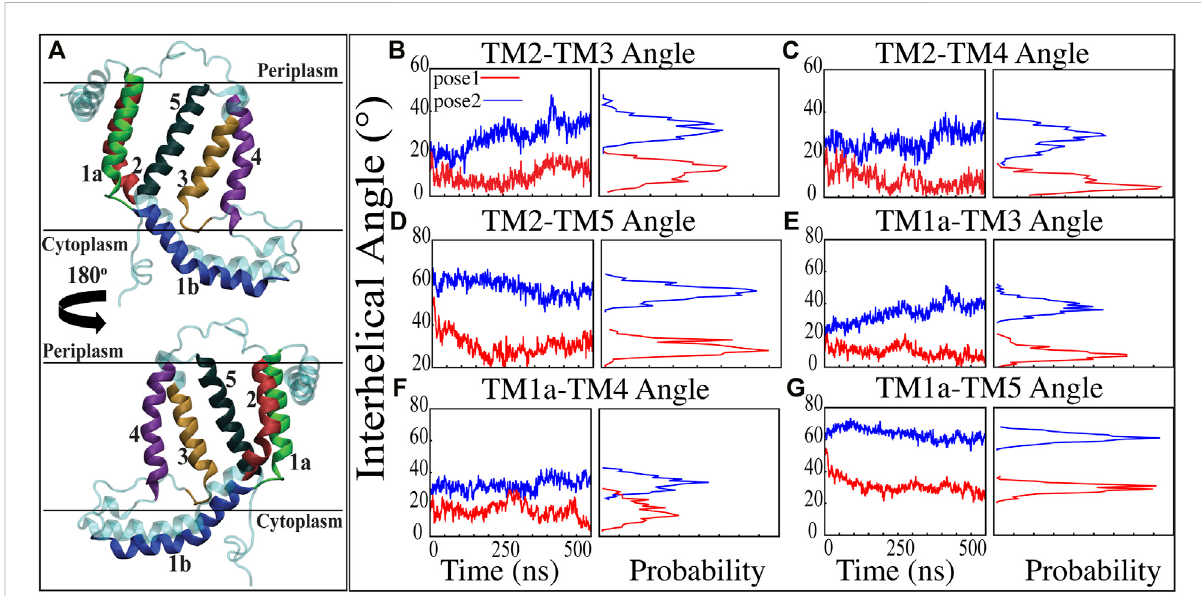
FIGURE 3 Inter-helical angles between trans-membrane helices of YidC in both docking model simulations. (A) Graphical representation of YidC protein on periplasmic, cytoplasmic and transmembrane regions labeled with helical numbers in the transmembrane region. (B – D) Overall inter-helical angle betweentransmembranehelix 2 and other helices of theprotein inpose 1 (red) and pose 2(blue) simulations. (E – G) Overall inter-helicalangle between transmembrane helix 1a and other helices of the protein in pose 1 and pose 2 simulations. Also, the probability density distribution is shown for all